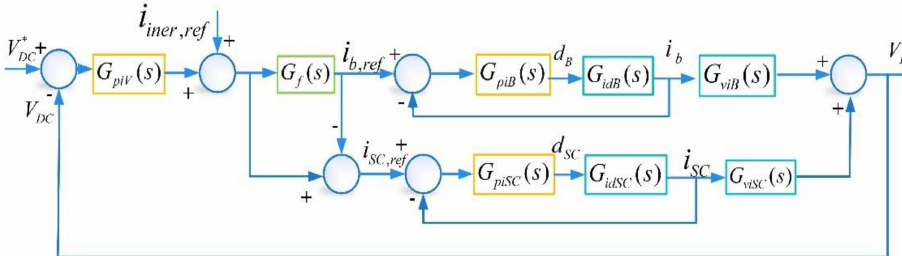
Figure 10. Small signal model of HESS